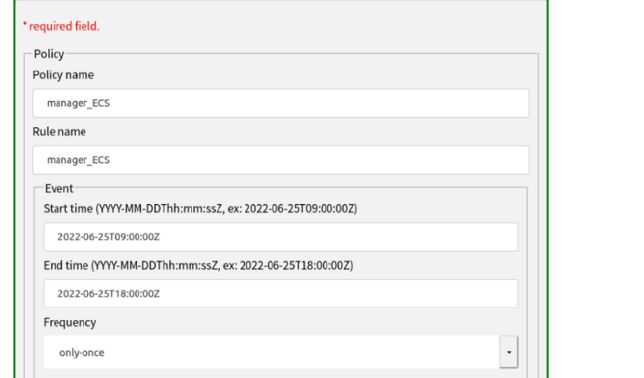
Figure 15. Data display of malicious behavior knowledge base. ( a ) Malicious traffic detection graph.